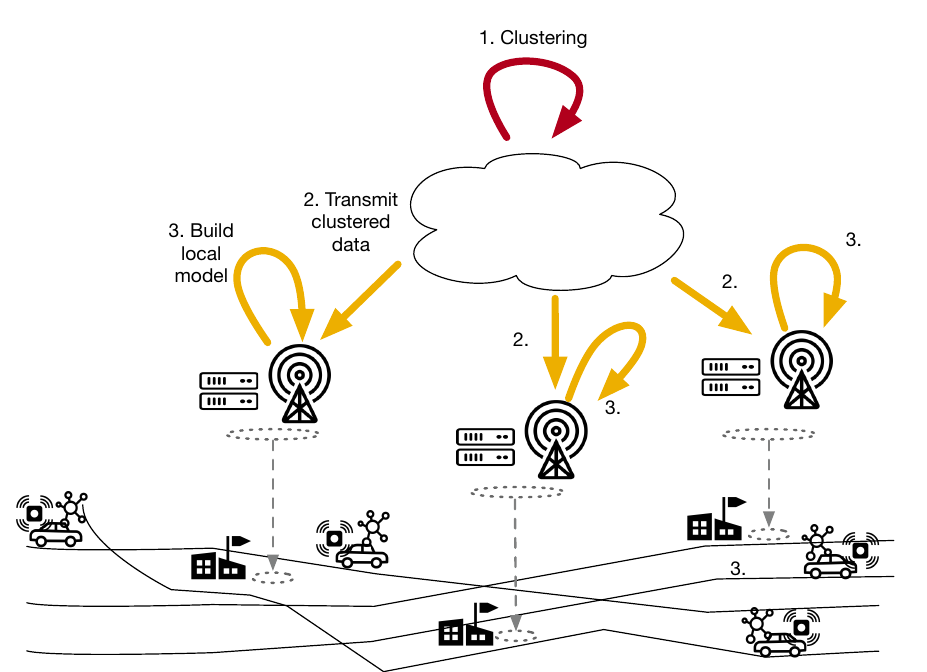
Figure 3. EDISON distributed learning. Cloud partitions the training set, the partitioned data is transmitted to the edge layer, and edge servers train local interpolation